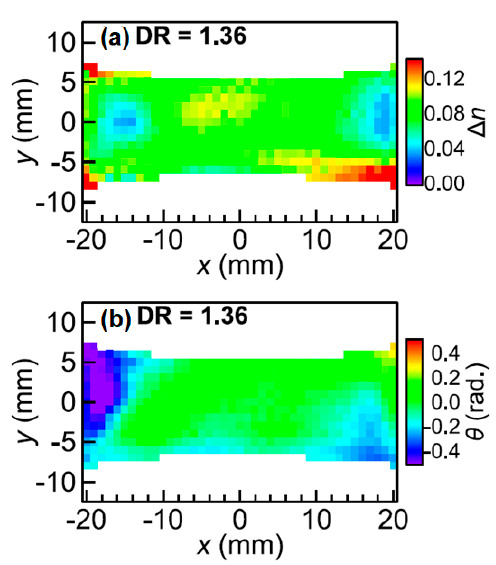
Figure 6. Spatial mapping of ( a ) the degree of birefringence and ( b ) the angle of the slow optic axis of a stretched black rubber sample. The draw ratio is 1.36. (Reprinted from reference [83] used in accordance with the Creative Commons Attribution (CC BY) license.)